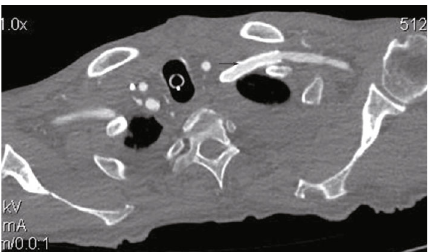
Figure 4: Postoperative CTA showed the proper position of the chimney graft inside the LSA (arrow) and the patency of the